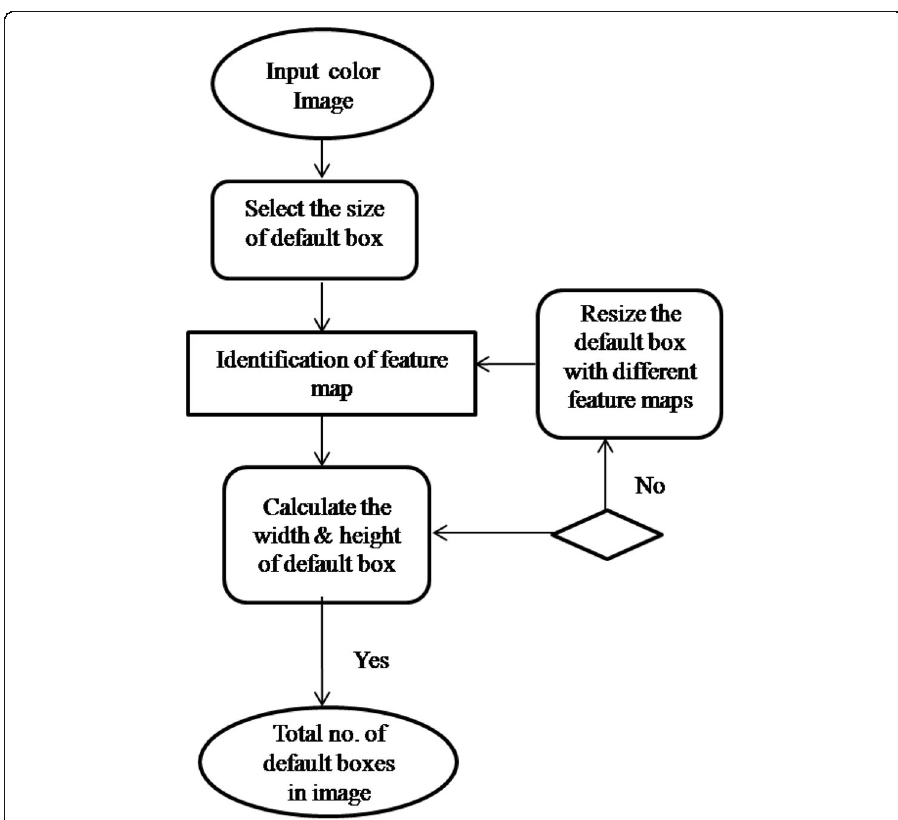
Fig. 4 Process of identifying total number of default boxes. Shows the process of identifying total number of default